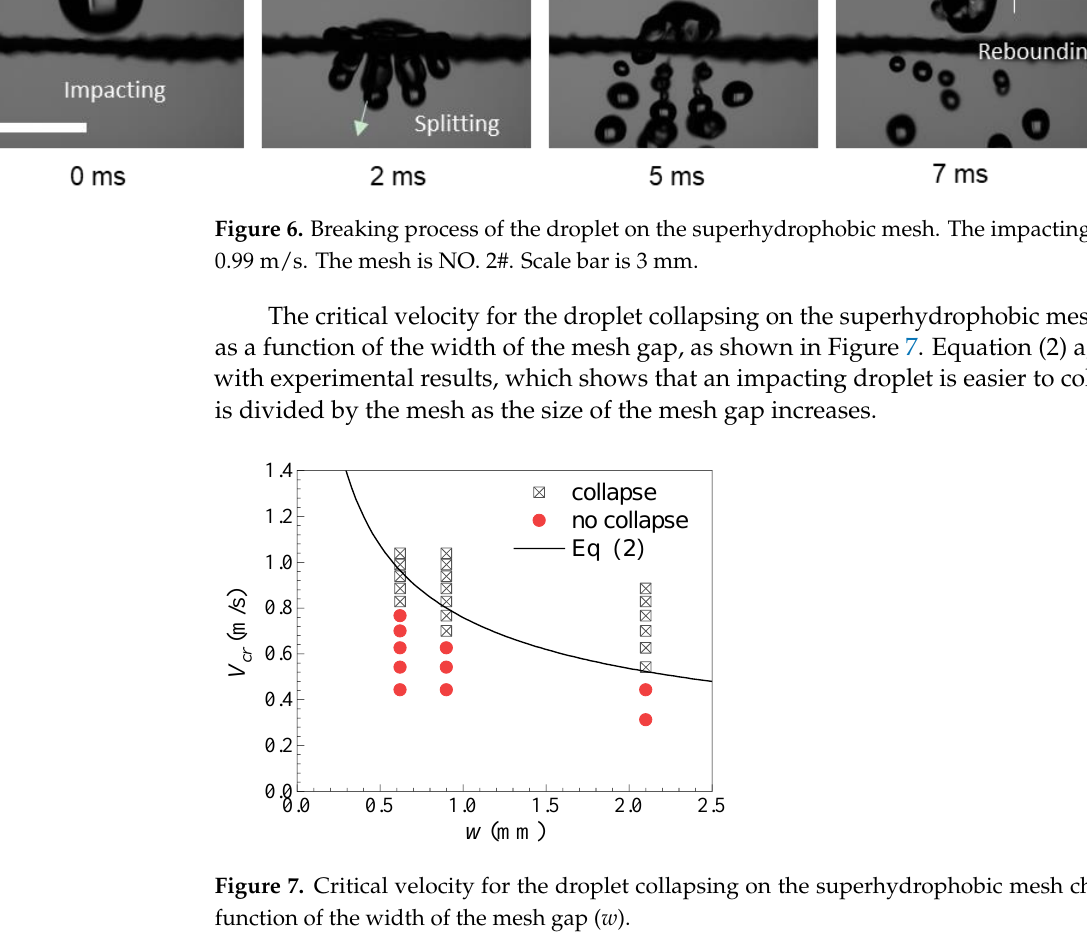
Figure 5. ( a ) Schematic diagram of the Laplace pressure that holds the water above the superhydrophobic mesh. ( b ) Instantaneous image of an impacting droplet on the superhydrophobic mesh (NO. 1#).